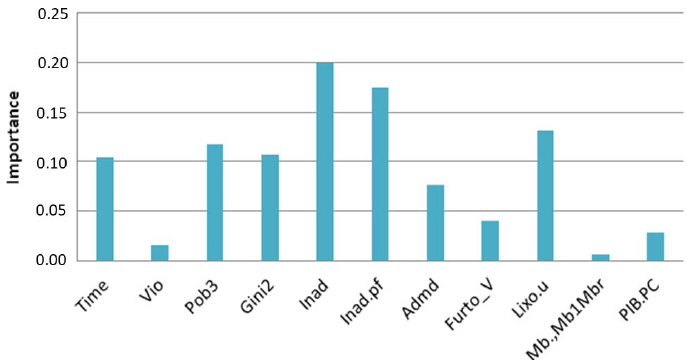
Figure 3. Importance of explanatory variables.